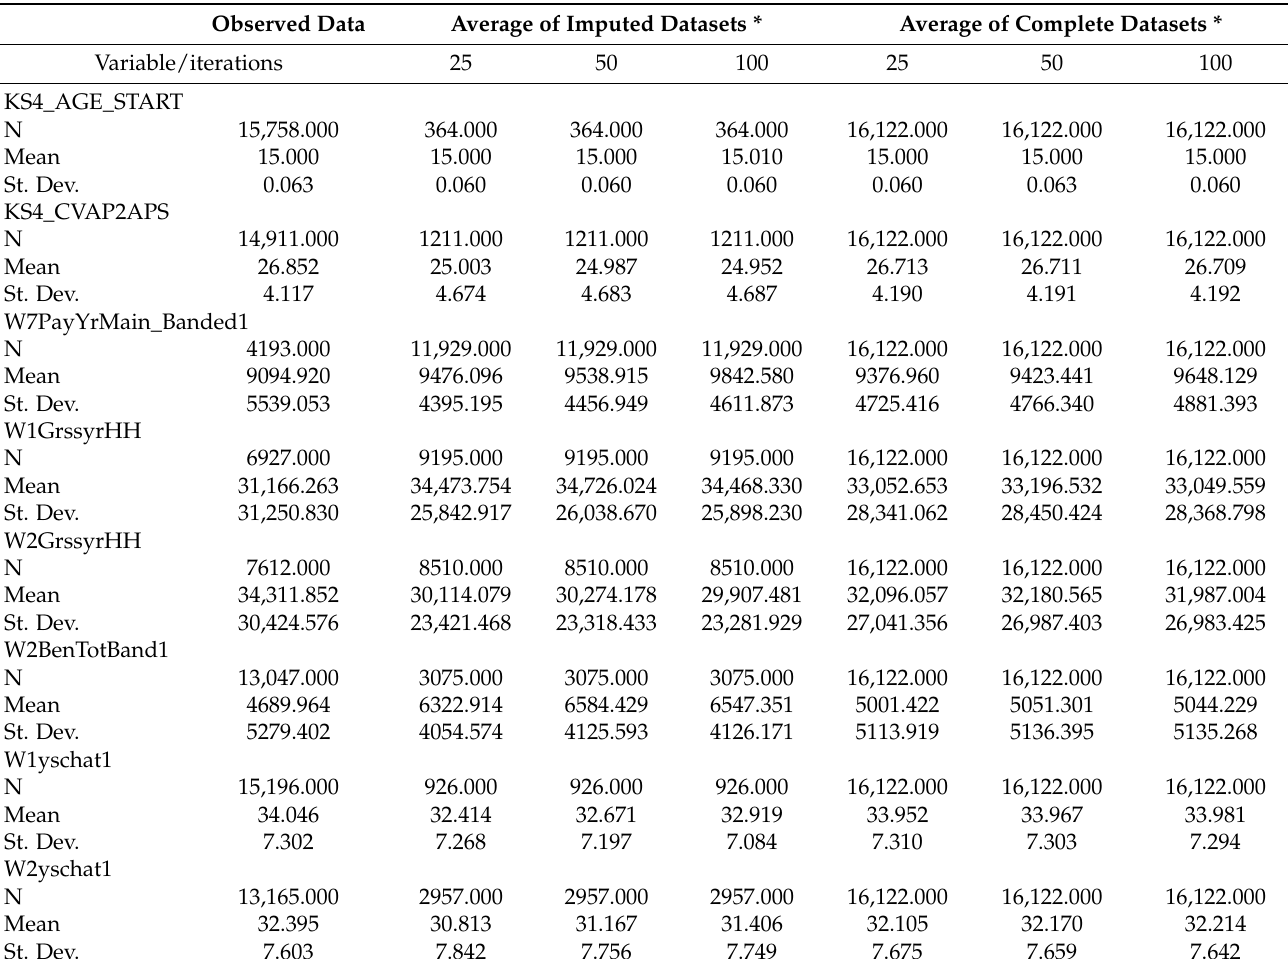
Table A1. Descriptive statistics for the observed data, the five imputed datasets and the five complete